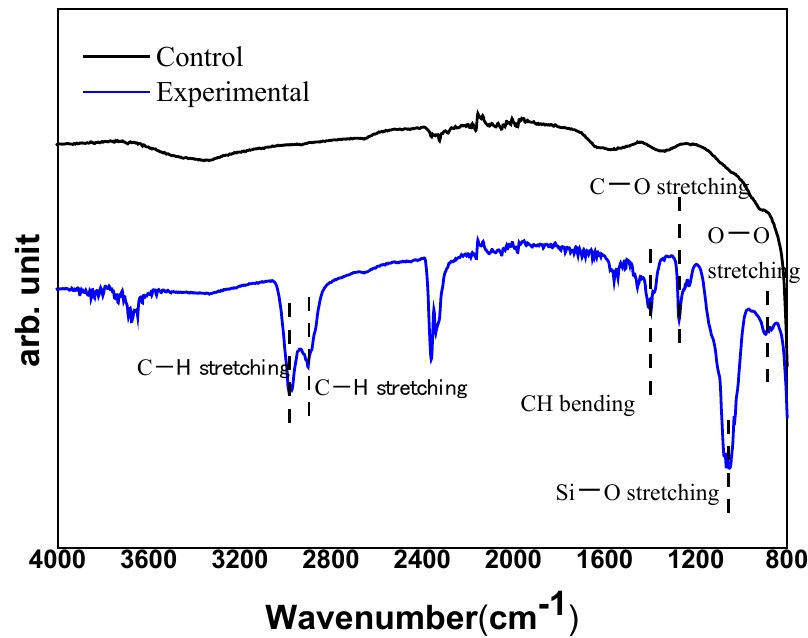
Figure 4. FT-IR spectra of the zirconia powder before and after silanization.